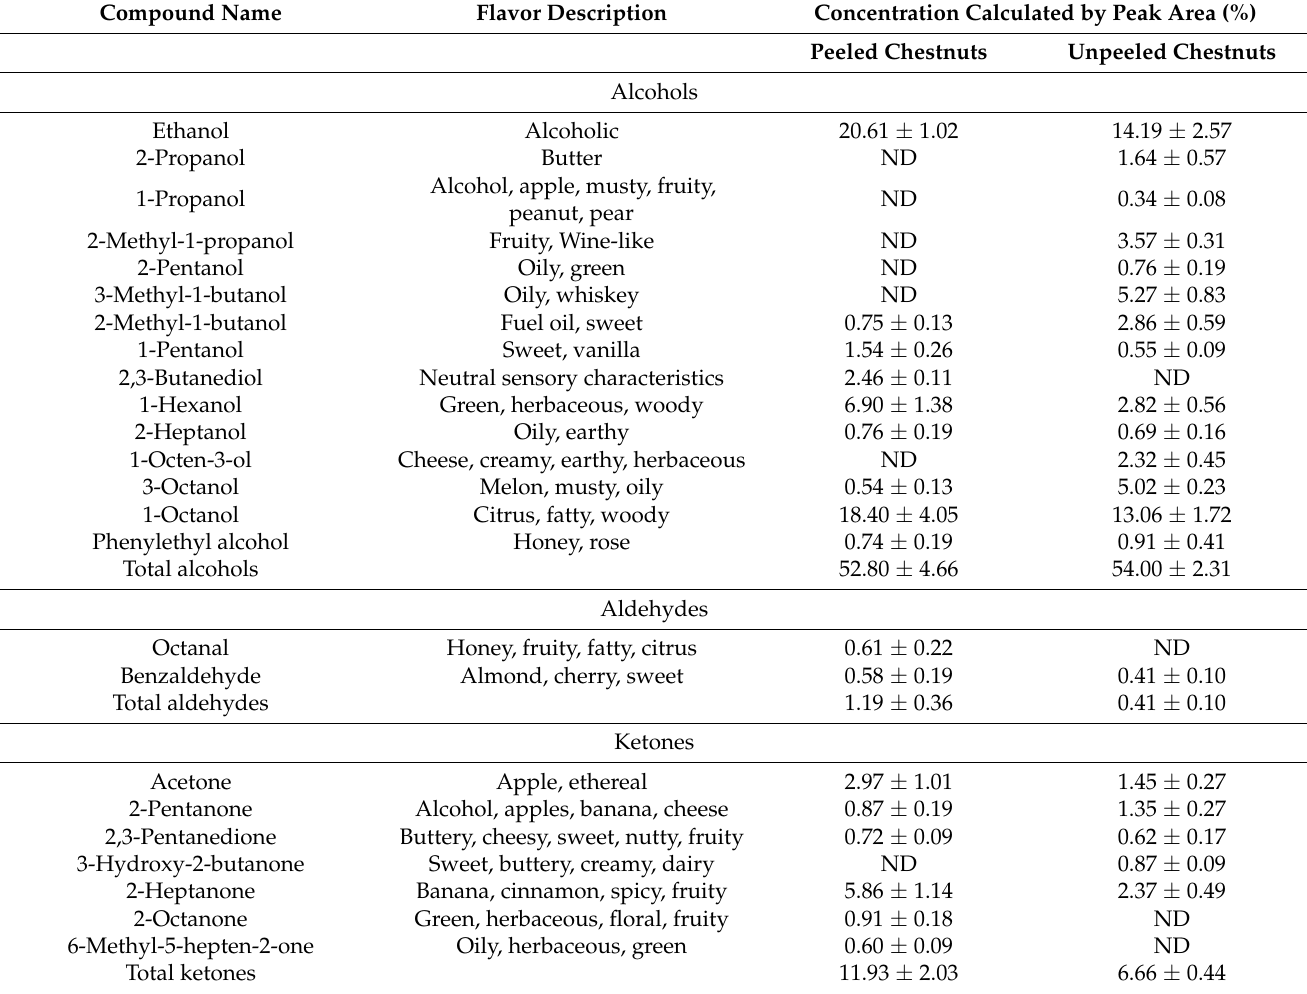
Table 2. The concentration of volatile compounds calculated by peak area (%) by solid phase microextraction (SPME) headspace analysis of triplicate extractions for shelled and unshelled raw chestnut seeds. Adapted from Muji´c et al.